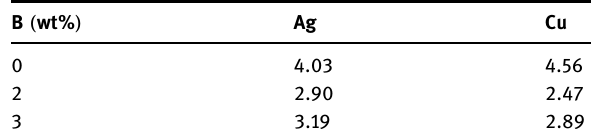
Table 4: Average grain size statistics for Ag ( s.s ) and Cu ( s.s ) in